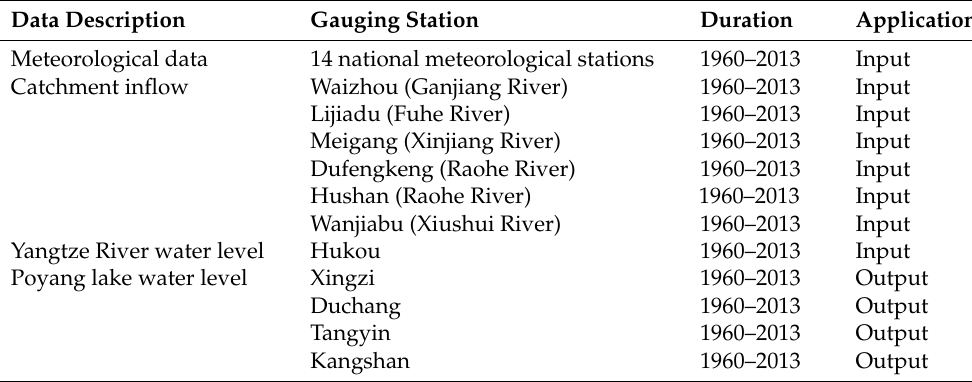
Table 1. Input data and output